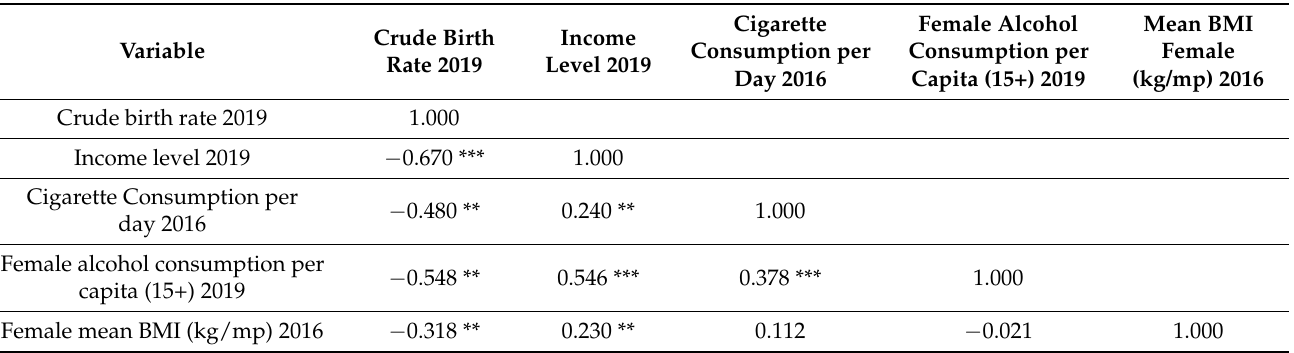
Table 4. Correlation matrix for all the variables in the model.